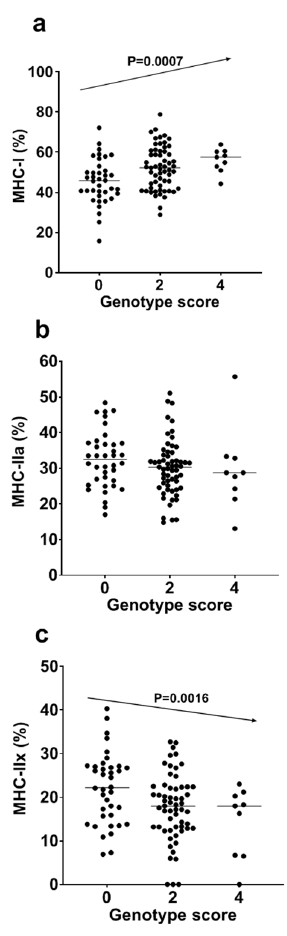
Figure 2. Genotype scores as combined effects of PPARGC1A rs8192678 G/A (Gly482Ser) (AA = 2 vs. GG + GA = 0) and NRF1 rs6949152 A/G (AA = 2 vs. AG + GG = 0) polymorphisms on MHC-I ( a ), MHC-IIa ( b ), and MHC-IIx content ( c ) in women. Table 3. Association of genotype scores with MHC-I, IIa, and IIx content in women. − Model